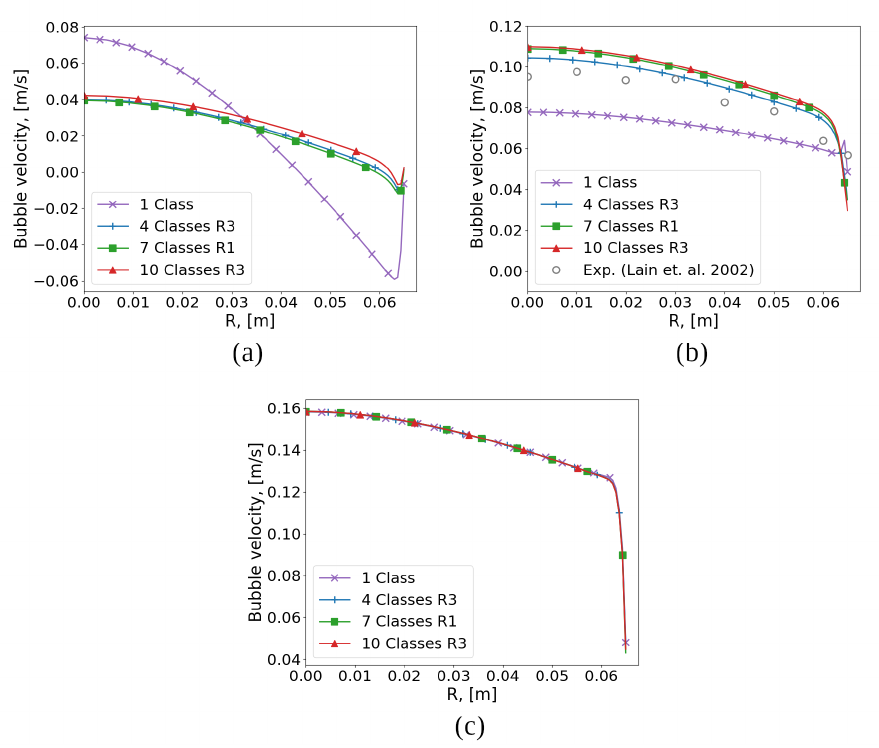
Figure 6. Radial profiles of bubble velocity in the reference cross-section (see Figure 1) for different characteristic bubble sizes: ( a ) M = 0.25 mm; ( b ) M = 0.5 mm; ( c ) M = 1.0 mm.